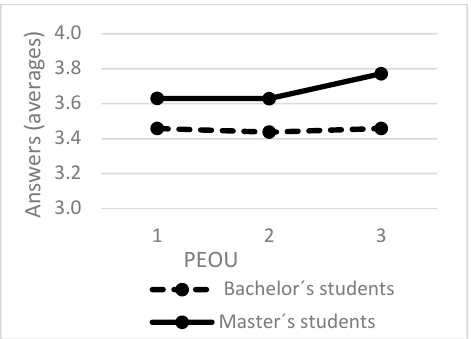
Figure 2. Answers of undergraduate and graduate students in PEOU (average values).